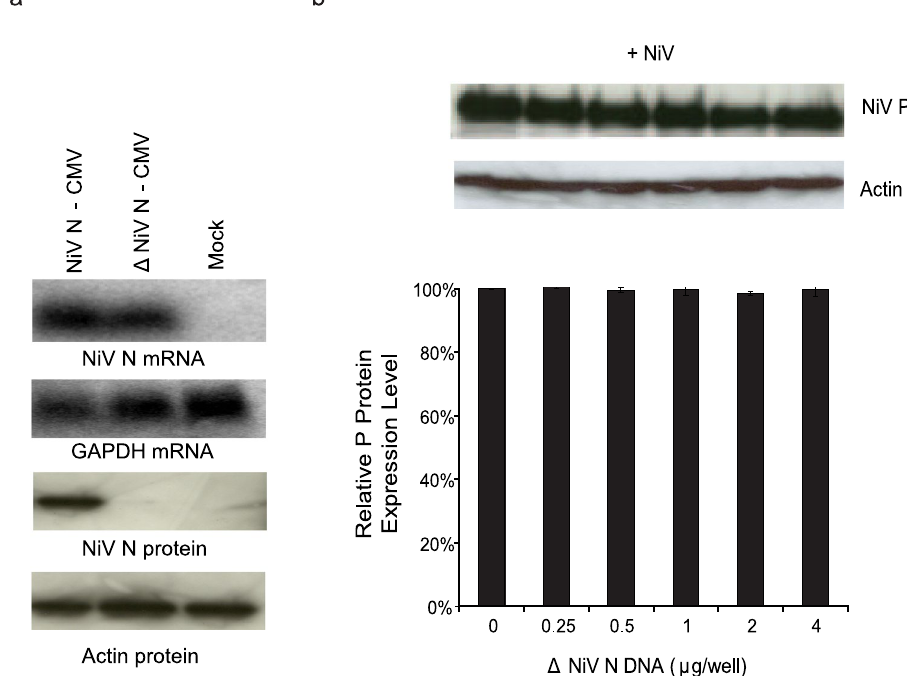
Figure 3. Effects of increasing NiV N mRNA on viral translation. ( a ) The translational start-sites of the NiV N gene were mutated to create an expression plasmid which produced NiV N transcripts but did not express NiV N proteins. 293 T cells were transfected with a NiV N competent expression plasmid (NiV N-CMV) and a NiV N incompetent expression plasmid ( ∆ NiV N-CMV) for 48 hours. RNA was extracted and a northern blot was performed to visualize the presence of NiV N mRNA. Total cell protein was harvested and a western blot preformed to visualize the presence of NiV N proteins. ( b ) Following transfections, a parallel set of cells were infected with NiV at an MOI of 1 and total cell protein was harvested 24 hours later. A western blot was performed to analyze the expression of NiV P proteins. Western blots were quantified by densitometry and normalized to actin. All experiments were carried out in triplicate and standard deviations of the mean were calculated. Blots have been cropped to ease